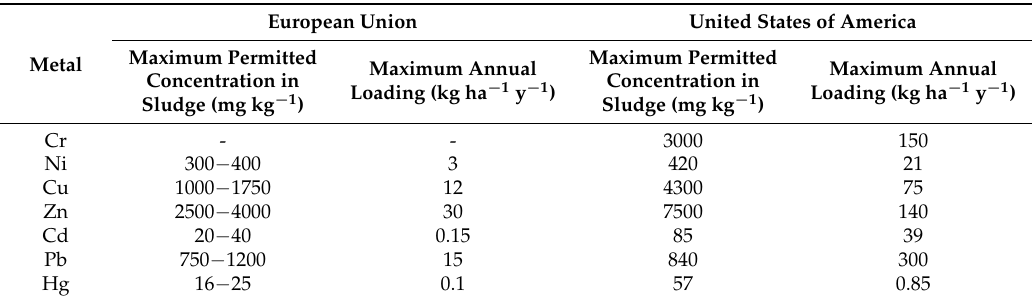
Table 2. Comparison of the limit values for heavy metal concentrations in biosolids for use in